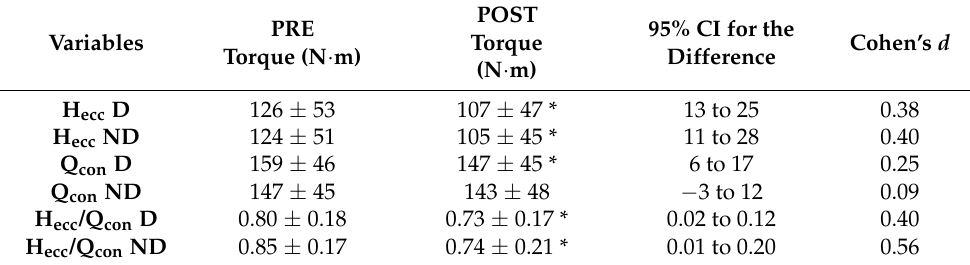
Table 2. Peak isokinetic data before (PRE) and after (POST) the simulated football exercise (BEAST 90